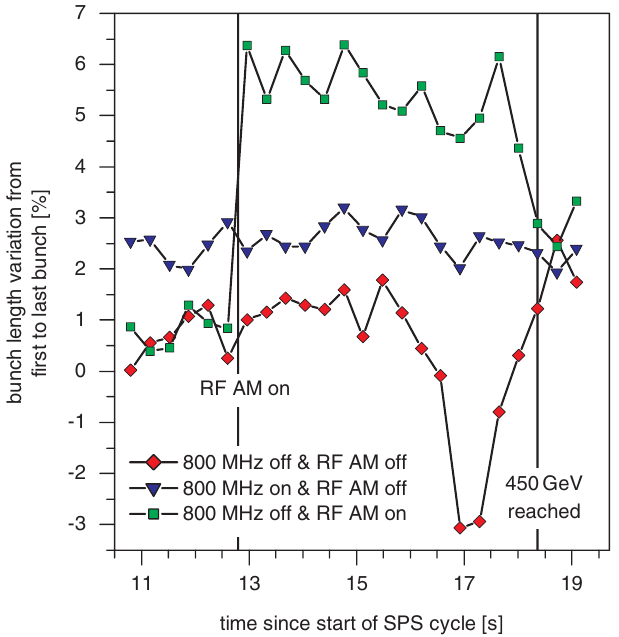
FIG. 12. (Color) Variation of bunch length ratio of first and last measured bunch within the SPS cycle.